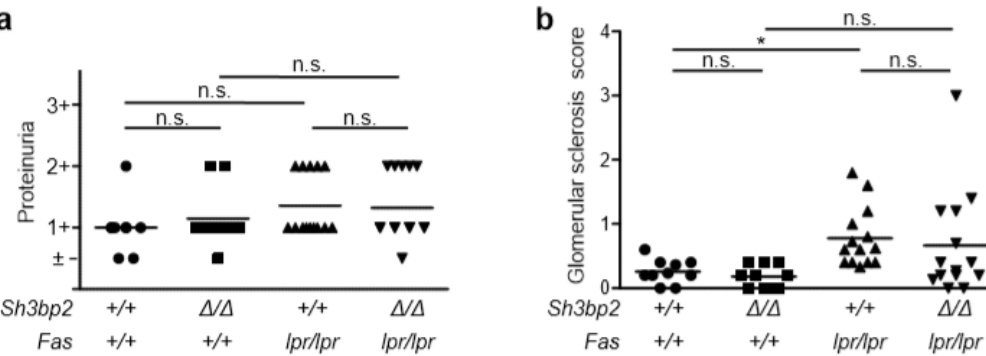
Figure A1. SH3BP2 mRNA and protein expression in immune cells. CD4 + T cells, CD8 + T cells, and B cells were isolated from the spleen of wild-type mice. Macrophages and dendritic cells were differentiated from bone marrow cells of wild-type mice. ( a ) Quantitative PCR analysis of Sh3bp2 . Sh3bp2 mRNA levels relative to that of Hprt were determined in each immune cell and were normalized to the expression level of CD4 + T cells. ( b ) Immunoblot analysis for SH3BP2 protein. Protein samples were collected from each immune cell subsets. Each protein sample (3.5 µ g per lane) were applied to the experiment. SH3BP2 was detected by its specific antibody. ACTIN was used as a loading control.